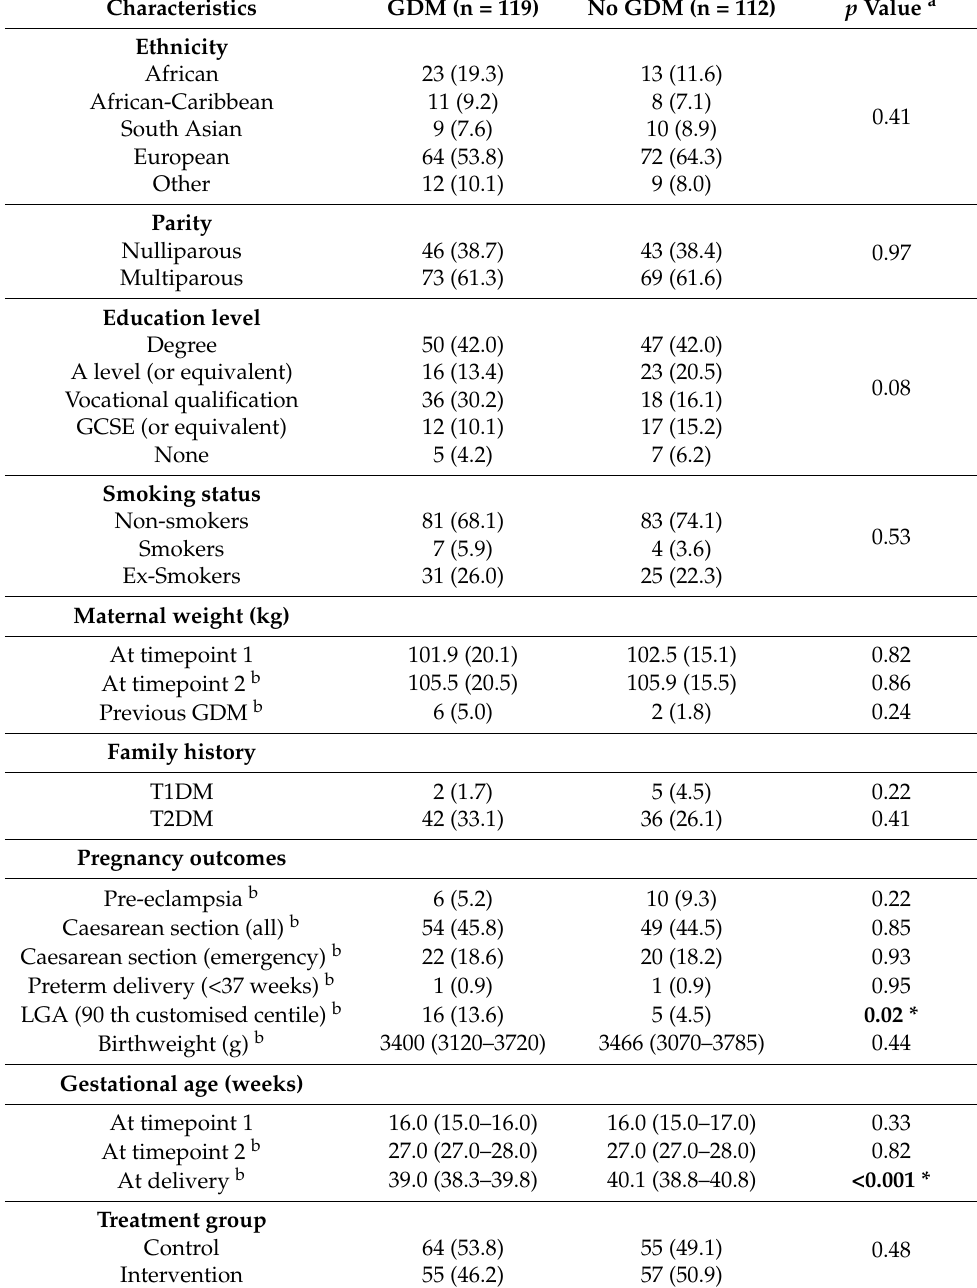
Table 1. Characteristics of high-risk women identified by the prediction tool who developed GDM and those who did not develop